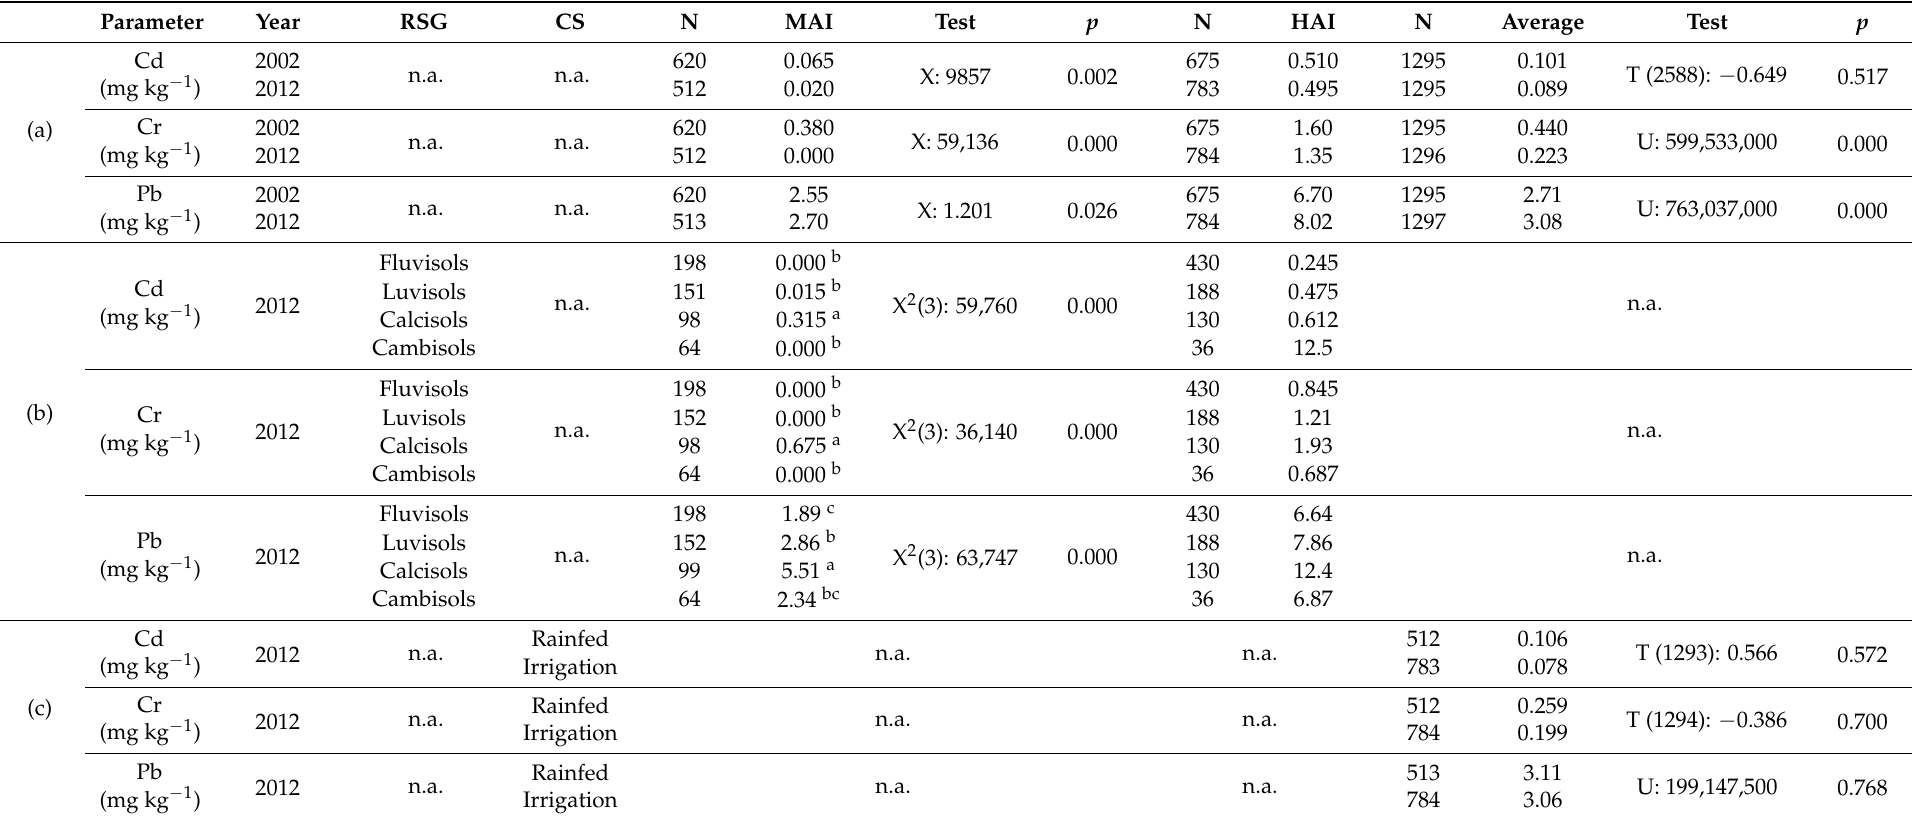
Table 1. Available Cd, Cr, and Pb concentrations ( a ) in 2002 and 2012 for MAI, HAI, and average; ( b ) MAI and HAI by RSG in 2012; ( c ) average by cultivation system in 2012; and ( d ) average by cultivation system and RSG in